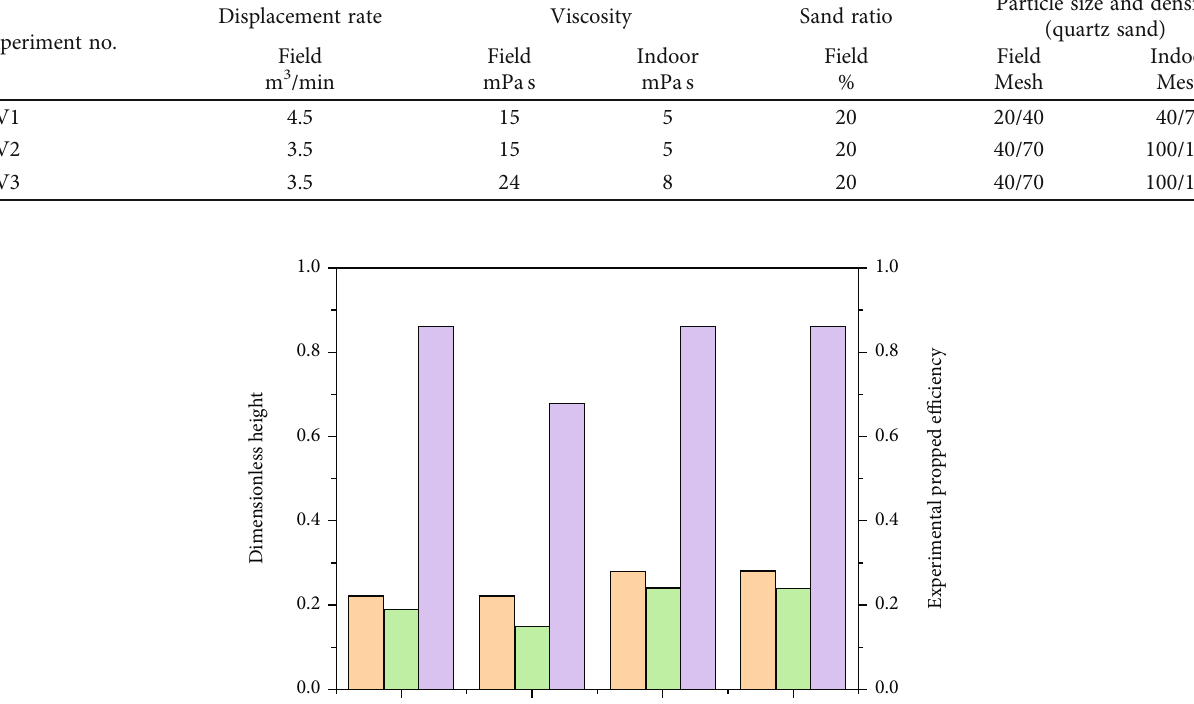
Table 8: Fracturing fl uid viscosity exploration experimental scheme of SLG H8. Experiment